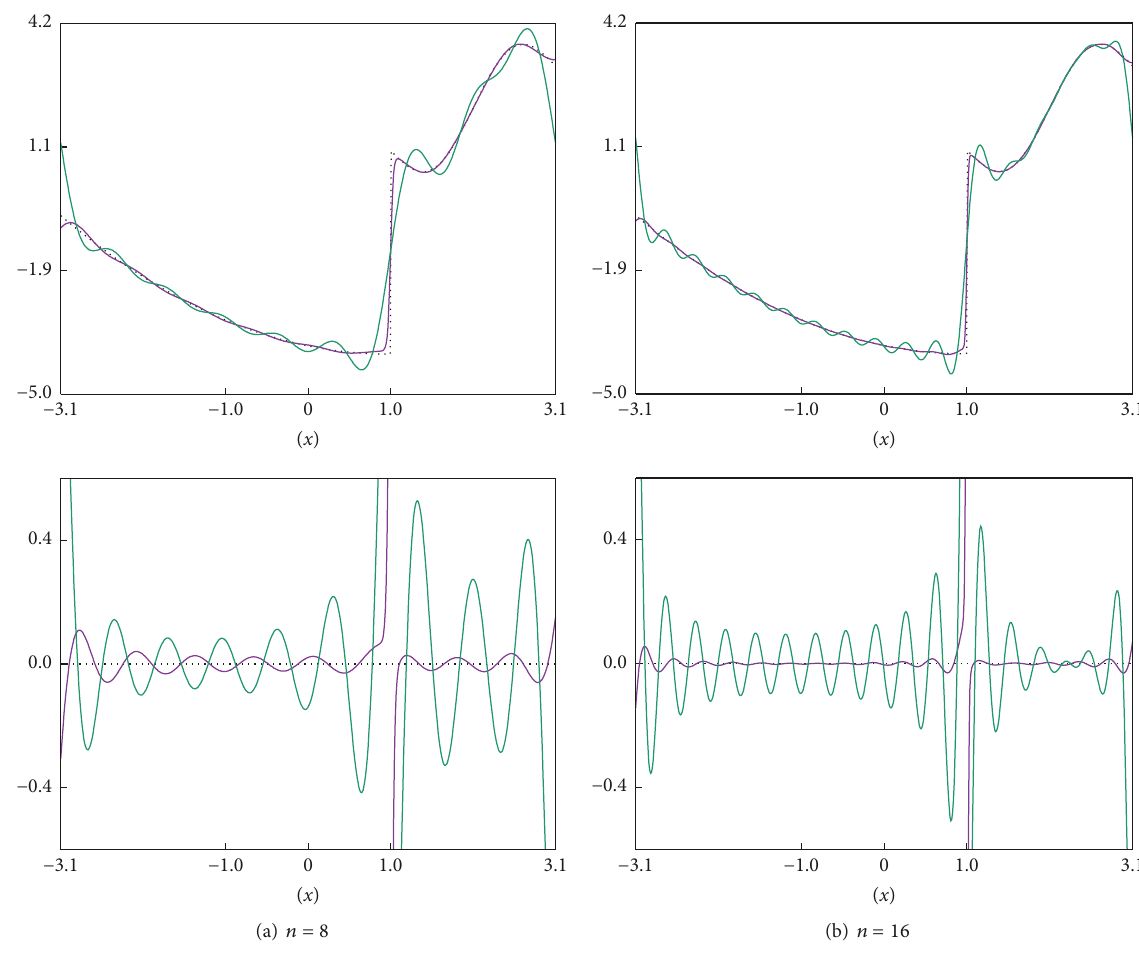
Figure 3: Approximations of the weighted average 𝐹 𝑛 (𝑥) in upper rows and the corresponding errors in lower rows for the test function 𝑓 1 (𝑥) . Thin lines indicate approximations and errors of the Fourier partial sum 𝑆 𝑛 𝑓(𝑥)